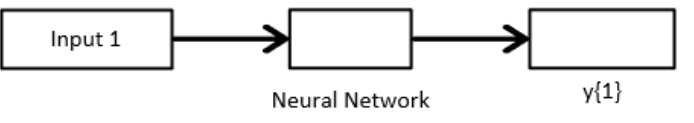
Figure 9. Generated proposed ANN model.